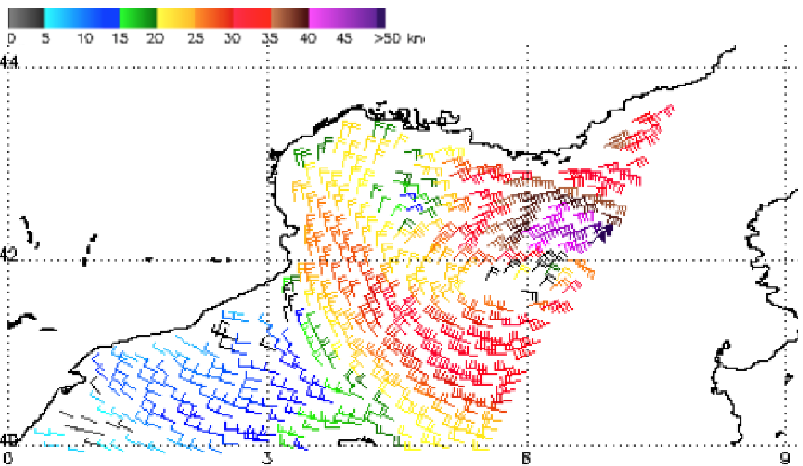
Figure 4. Wind speed and direction from the Advanced Scatterometer Wind data (ASCAT) shown on 8 November 10:00 UTC at 25 km of resolution. In the proximity of the pressure minimum, wind speed is approximately 25–28 ms −1 (50–55 knots). The area with maximum intensity is located on the northern side of TLC.